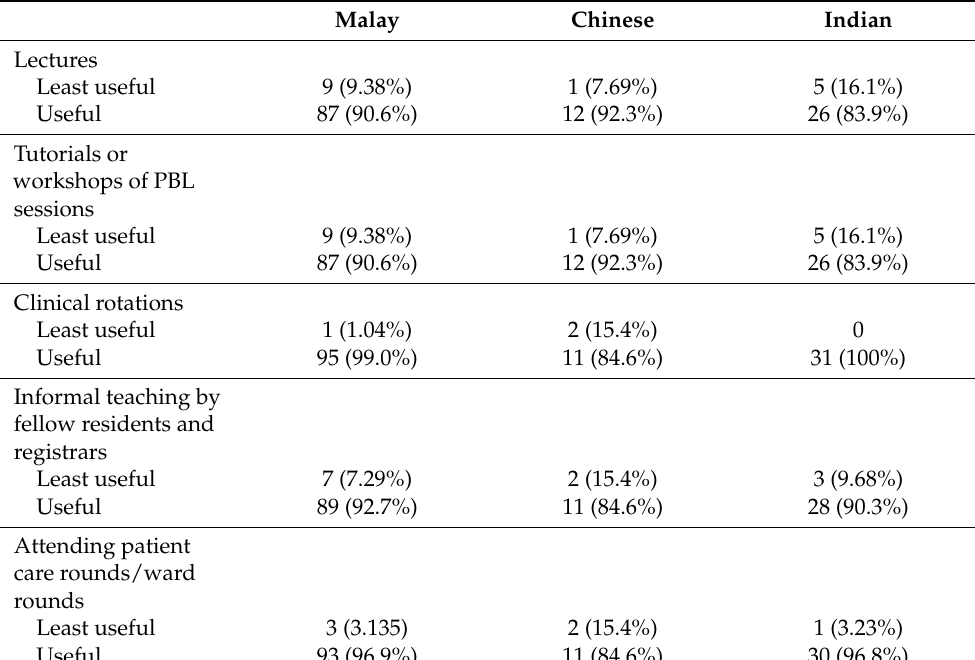
Table 7. Frequency and odds of student years in the relative effectiveness of various delivery modes in gaining and retaining the knowledge of medicines and prescribing, including but not limited to antibiotics